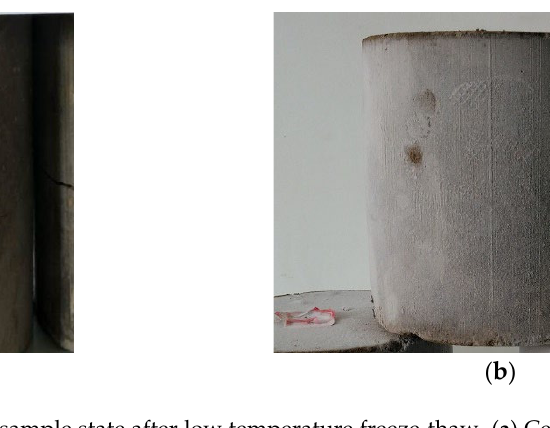
Figure 9. Relationship between water loss rate and dry shrinkage strain. Figure 7 exhibits the shrinkage strain variation of silt and stabilized soil with time.